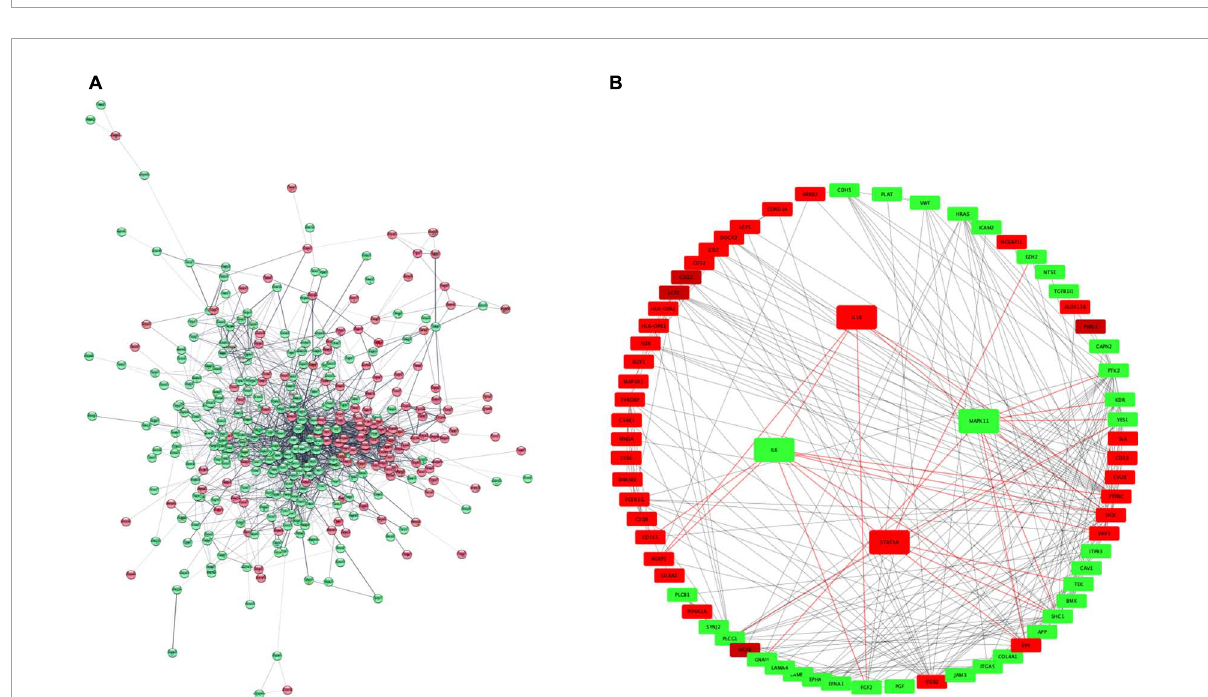
FIGURE5 PPI network representation of 407 DEGs (A) . The network was constructed by STRING and visualized in Cytoscape. Hub proteins network (B) according to CytoHubba MCC coefficient. Red and green color represent upregulated and downregulated proteins. PPI, protein-protein interaction; MCC, maximum clique centrality. Red color represents up-regulated genes and green color down-regulated.